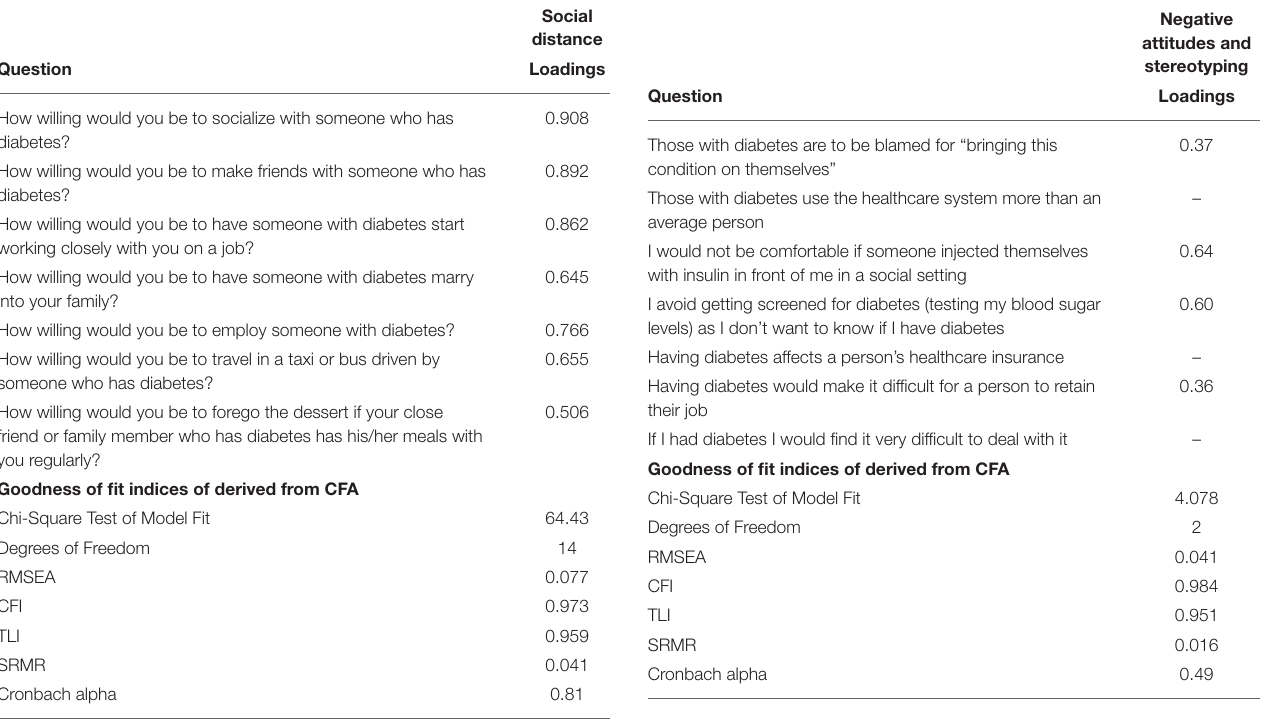
TABLE 3B | Factor loadings and goodness-of-fit indices of the final model of the negative attitudes and stereotyping scale.